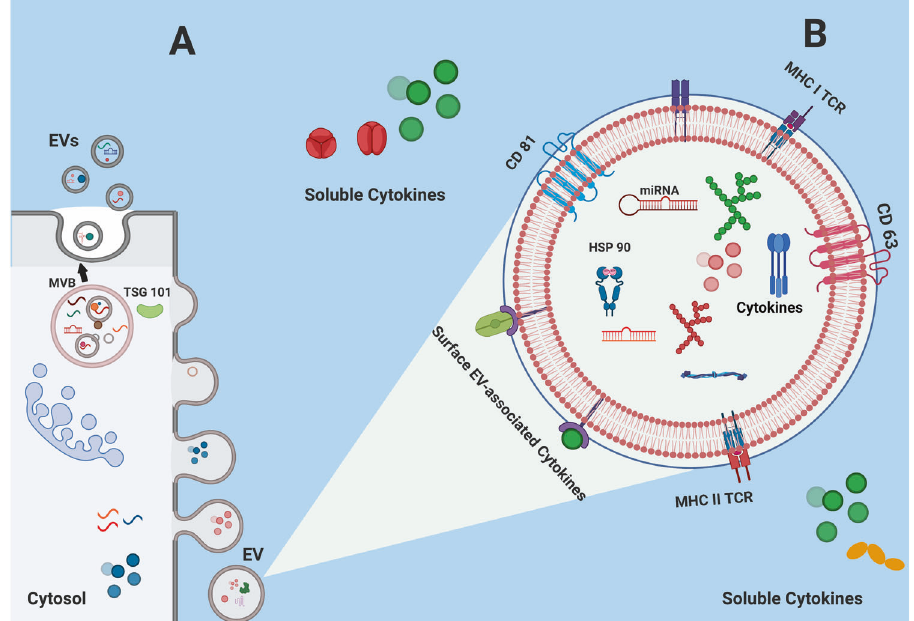
Fig. 1 Illustration of extracellular vesicles (EV). A . Release of EVs from multivesicular body (MVB); B EV with common genetic components and proteins including cytokines [12,